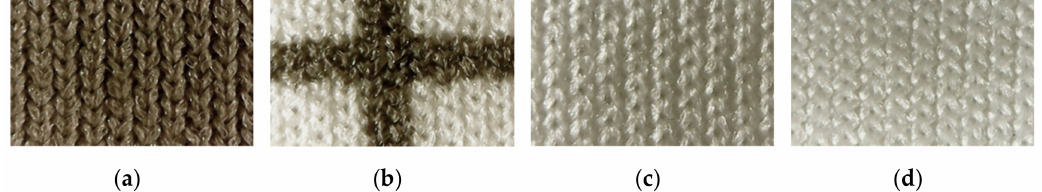
Figure 1. Optical microscope images of treated fabrics outer surface: ( a ) C1 , ( b ) C2 , ( c ) C3 , ( d ) C4